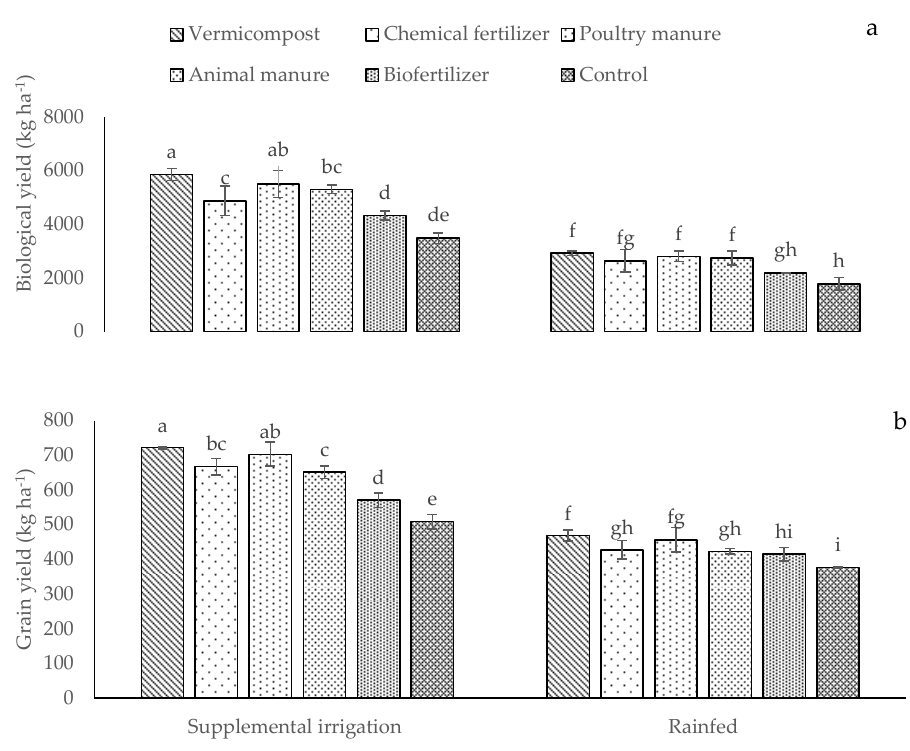
Figure 7. Means ( ± Standard deviation, SD) comparison for the interaction impacts of fertilizer and irrigation conditions on biological ( a ) and grain ( b ) yields. The means with dissimilar letters vary significantly at p ≤ 0.05 based on Tukey’s HSD test.